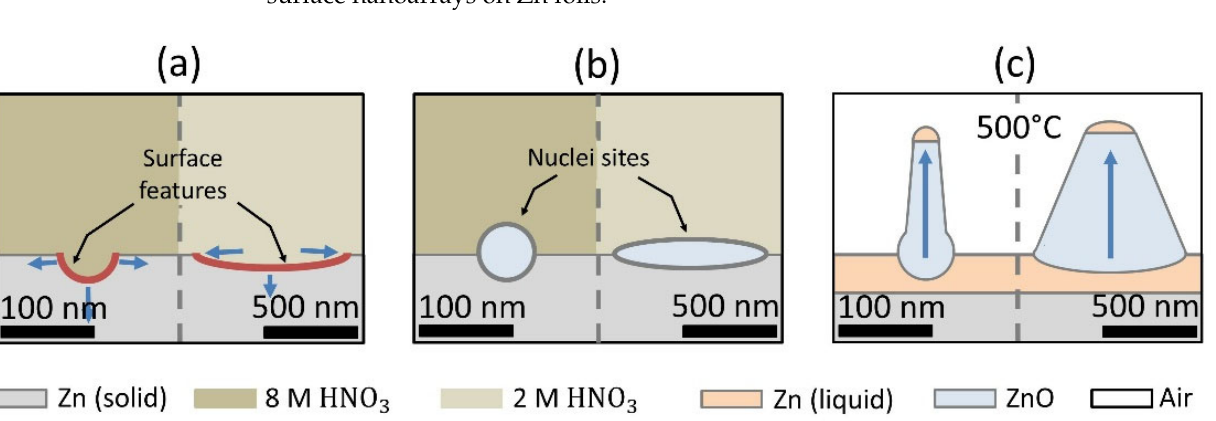
Table 1. Comparison of Raman shift values for vibrational modes between the as-oxidized ZnO structures previously etched with 2 M (ZnO-g) and 8 M (ZnO-c) HNO 3 solutions. Note that * point